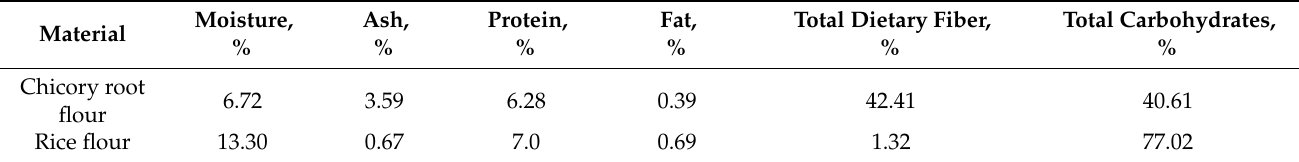
Table 1. Proximate composition of raw